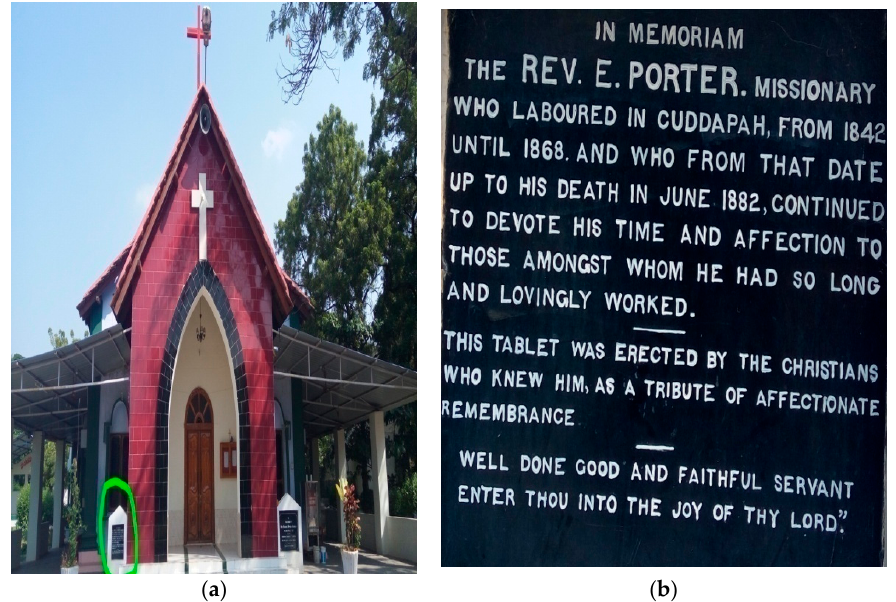
Figure 4. ( a , b ) Tablet which is erected in 1884 in the church building in memory of missionary Edward Porter (Photo by the author).